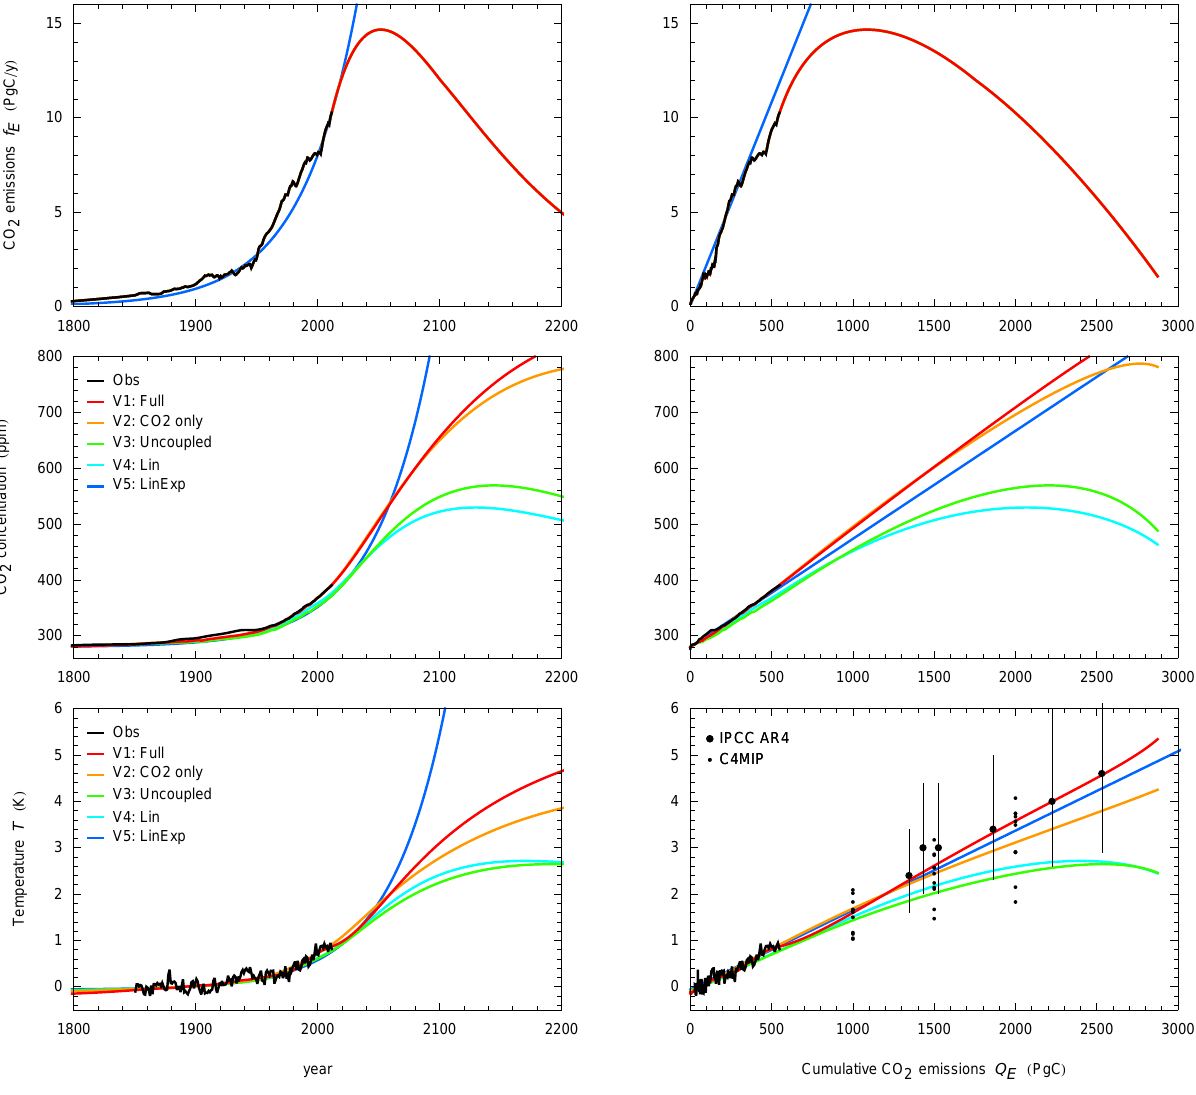
Fig. 8. SCCM predictions of [CO 2 ] and T with successive simplification of process descriptions, from a full model to the LinExp idealisation. Model versions: (V1, red) full model; (V2, orange) CO 2 only; (V3, green) uncoupled; (V4, sky blue) Lin; (V5, dark blue) LinExp. Prescribed total CO 2 emissions trajectories are identical for versions V1 to V4 (the case Q E ( ∞ ) =3000PgC in Fig. 6), and are exponential for V5. Other details as for Fig. 6. Data sources: Appendix